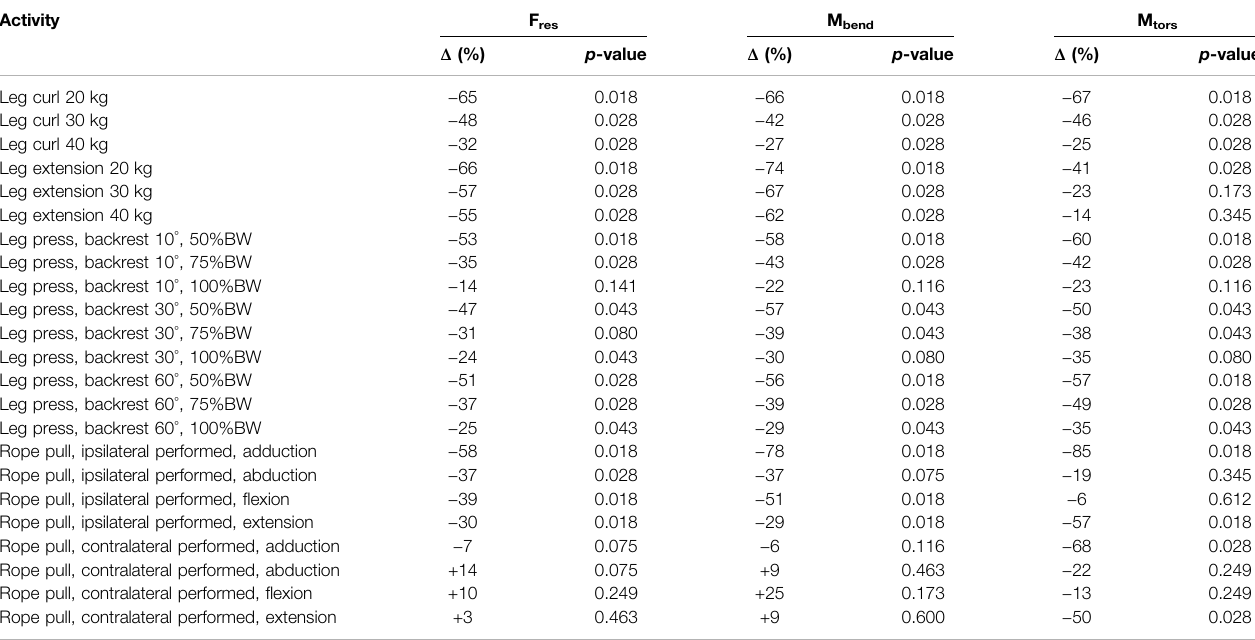
TABLE 2 | Reference activity walking versus each investigated activity depicting the resultant force F res , bending moment M bend , and torsion torque M tors with the results givenasdelta Δ (%)ofthemedianpeakvaluesinrelationtowalking,bold — invivo measuredpeakvaluesaresigni fi cantlysmallerrelativetowalking invivo measuredpeak